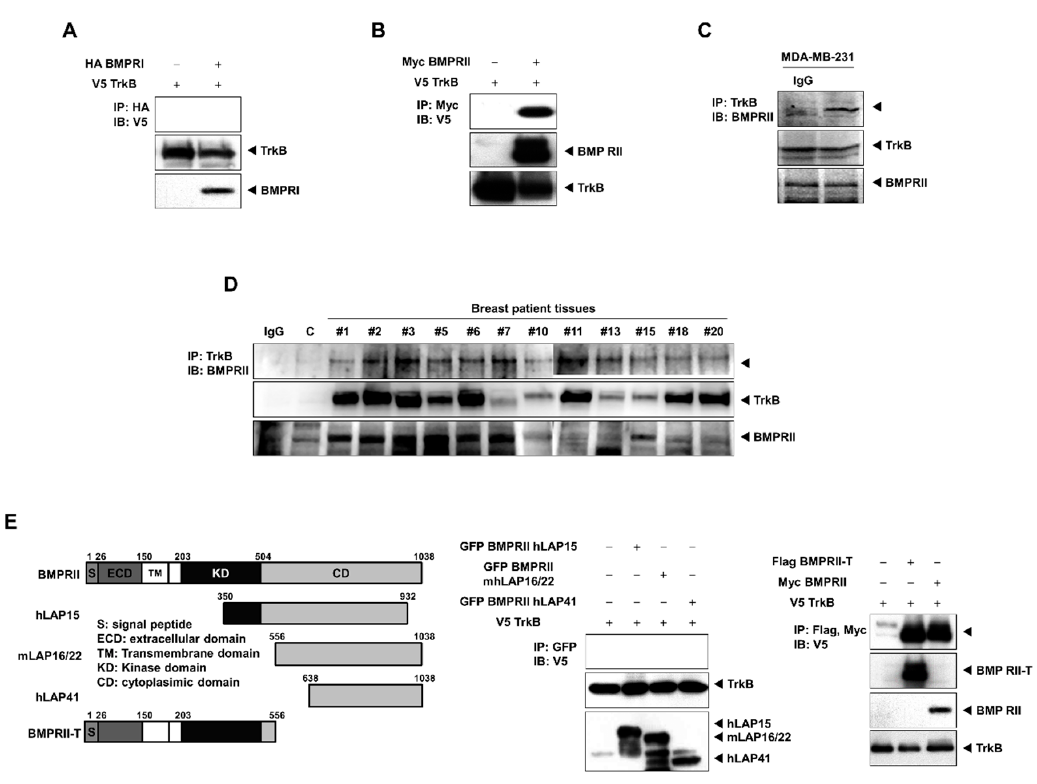
Figure 3. TrkB inhibited BMP signaling following BMP-2 treatment by blocking the interaction between BMP type I receptor (BMPRI) and BMP type II receptor (BMPRII). ( A ) Western blot analysis of whole-cell lysates and hemagglutinin (HA)-tagged immunoprecipitates verifying the presence of V5-TrkB and HA-BMPRI constructs in 293T transfected cells. ( B ) Western blot analysis of whole-cell lysates and Myc-tagged immunoprecipitates verifying the presence of V5-TrkB and Myc-BMPRII constructs in 293T transfected cells. ( C ) The formation of endogenous TrkB-BMPRII complexes in MDA-MB-231 cells, as shown by Western blots of whole-cell lysates and TrkB immunoprecipitates. ( D ) The formation of endogenous TrkB-BMPRII complexes in the tumor tissues of breast cancer patients, as shown by Western blots of whole-cell lysates and TrkB immunoprecipitates. ( E ) The identification of the BMPRII region that interacted with TrkB. Western blot analysis of whole-cell lysates and green fluorescent protein (GFP)-, Flag-, or Myc-tagged immunoprecipitates obtained from 293T cells transfected with V5-TrkB, Myc-BMPRII, or a BMPRII-deleted construct.